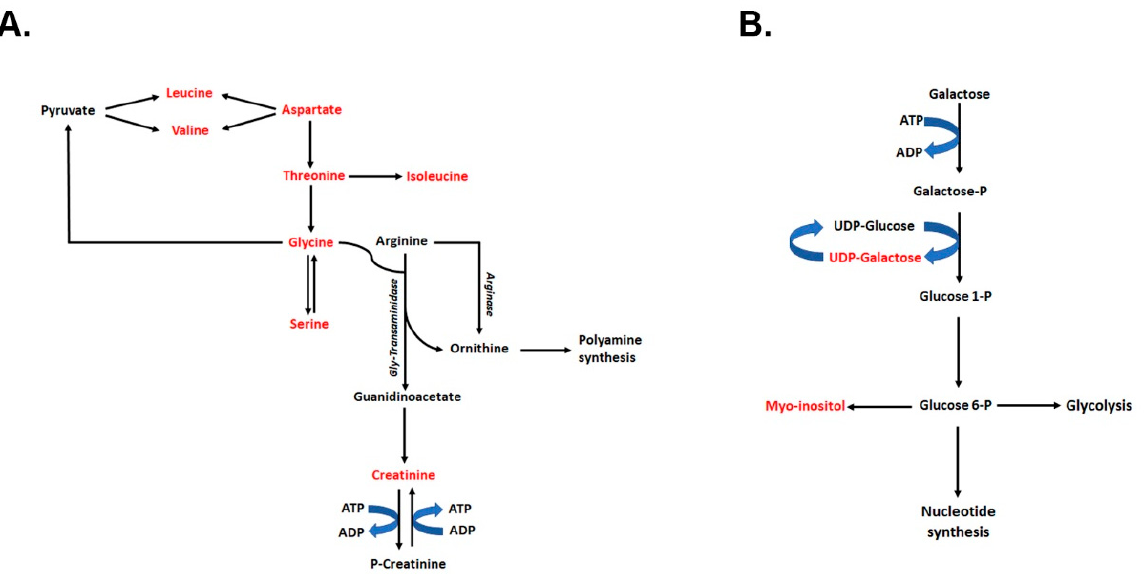
Figure 7. Potential metabolic pathways affected based on altered metabolite levels in the current study. ( A ) Reduction in creatine levels may be due to renal parenchymal damage in Tsc1 KO mice. The reduction in creatine can directly affect the phosphagen pathway and energy storage in other tissues and indirectly affect the renal function. The synthesis of polyamines is not affected in Tsc1 KO mice. ( B ) The reduction in UDP-Galactose can adversely affect the Leloir pathway, altering the generation of glucose 1-phosphate and ultimately the production of myo-inositol. The reduced levels of UDP-galactose may also lead to problems with the post-translational glycosylation process. Metabolites that were shown to be significantly altered in the kidneys of Tsc1 KO mice are identified in red font.